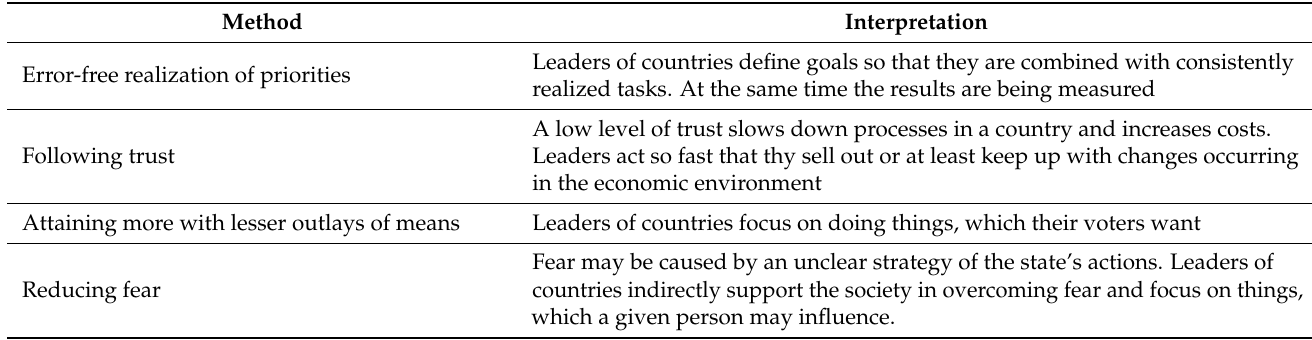
Table 2. Methods to avoid threats in sustainable energy development policy.